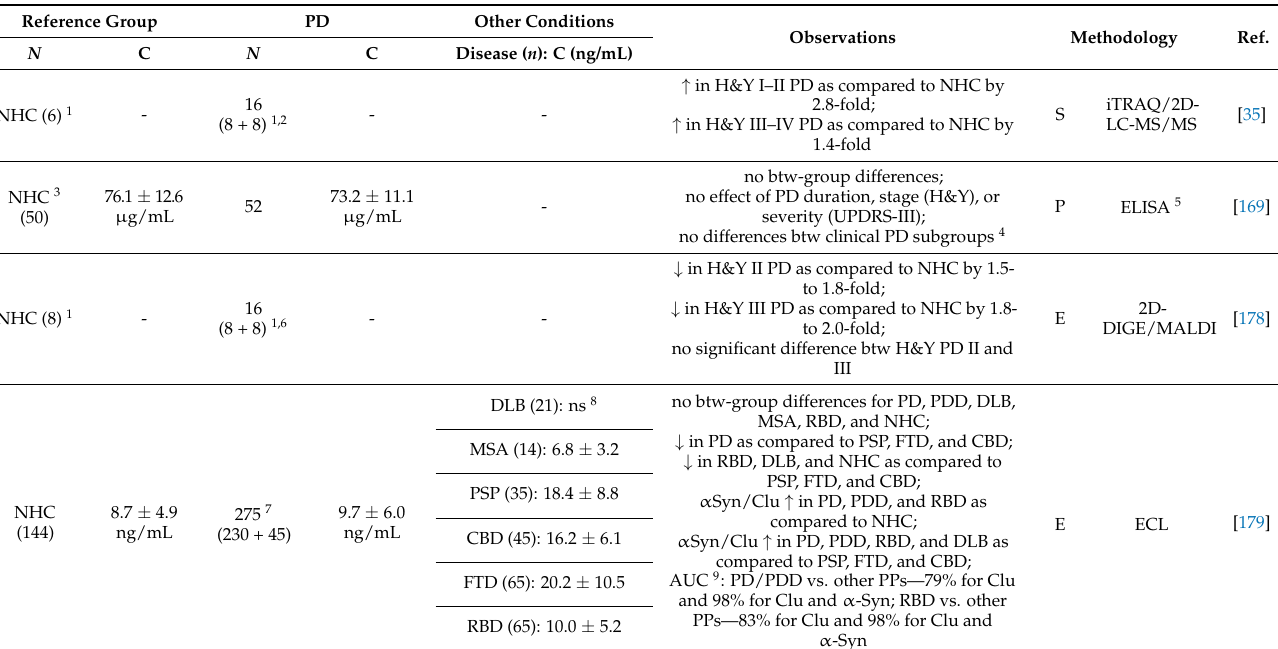
Table 2. Summary of studies on systemic clusterin in Parkinson’s